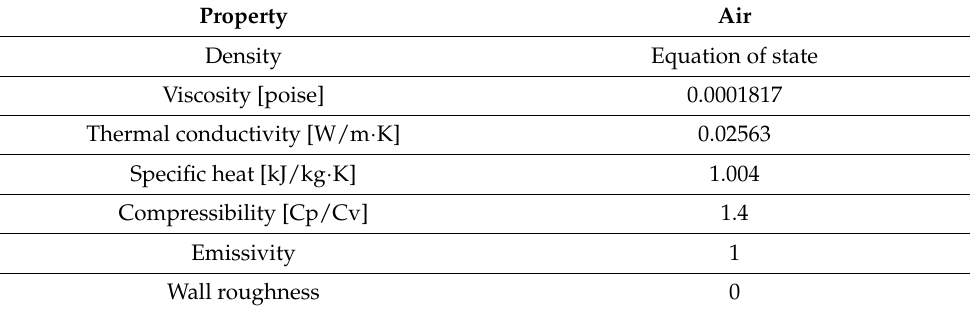
Table 4. Thermophysical properties of the HTF (air) implemented in CFD.